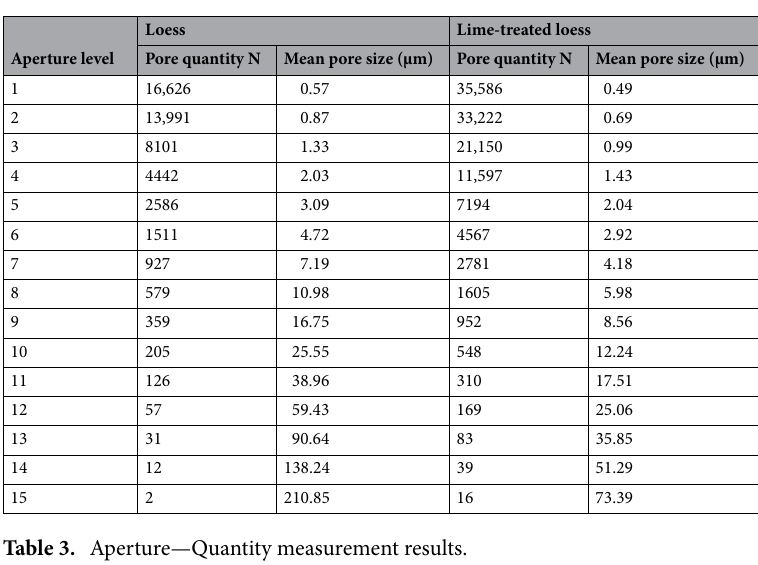
Table 3. Aperture—Quantity measurement results.